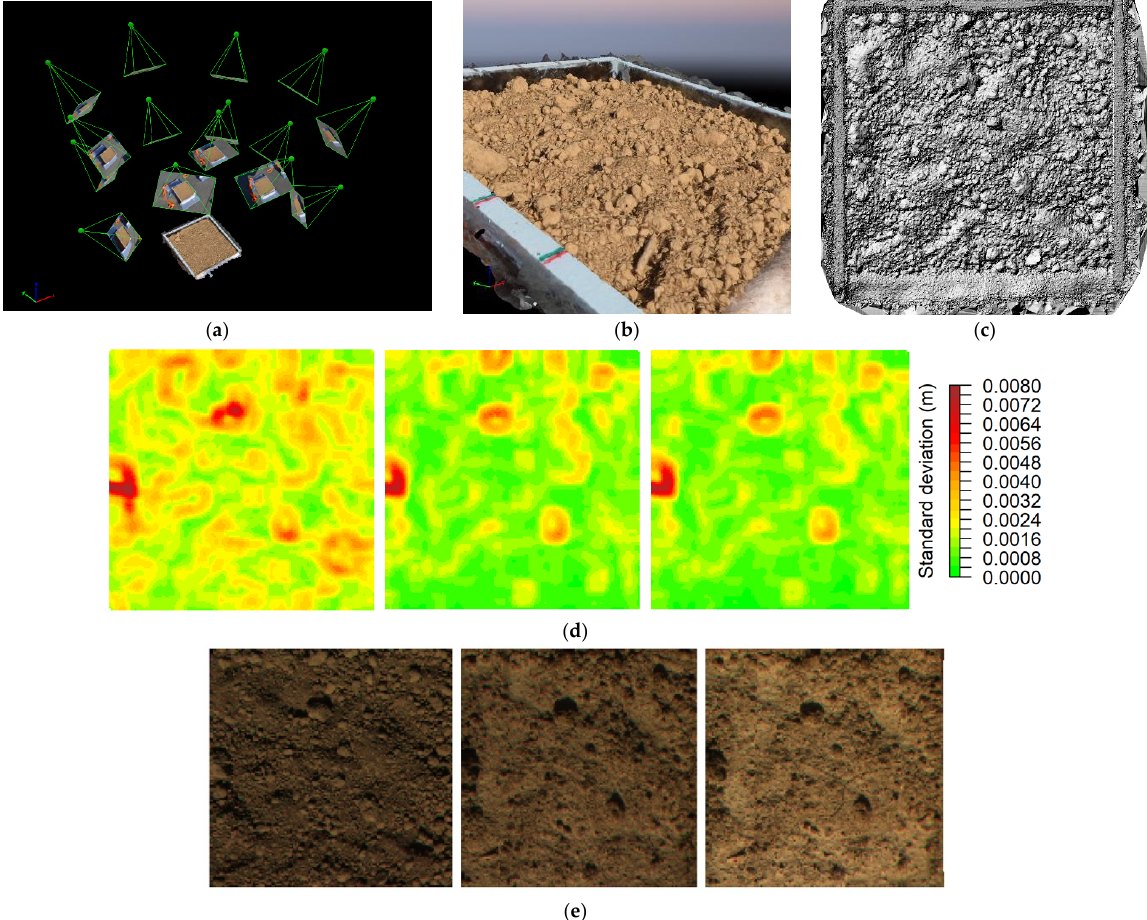
Figure 3. Roughness characterization using photogrammetry: ( a ) an illustration of the 3D mesh and the estimated positions of the camera; ( b ) detailed view of the 3D mesh from close distance; ( c ) DTM with hillshade representation. In the middle ( d ) an example of random roughness map, for the same soilbox, in three subsequent phases (left to right: before, after first and after second rainfall application) and, on the bottom ( e ), their corresponding RGB images.